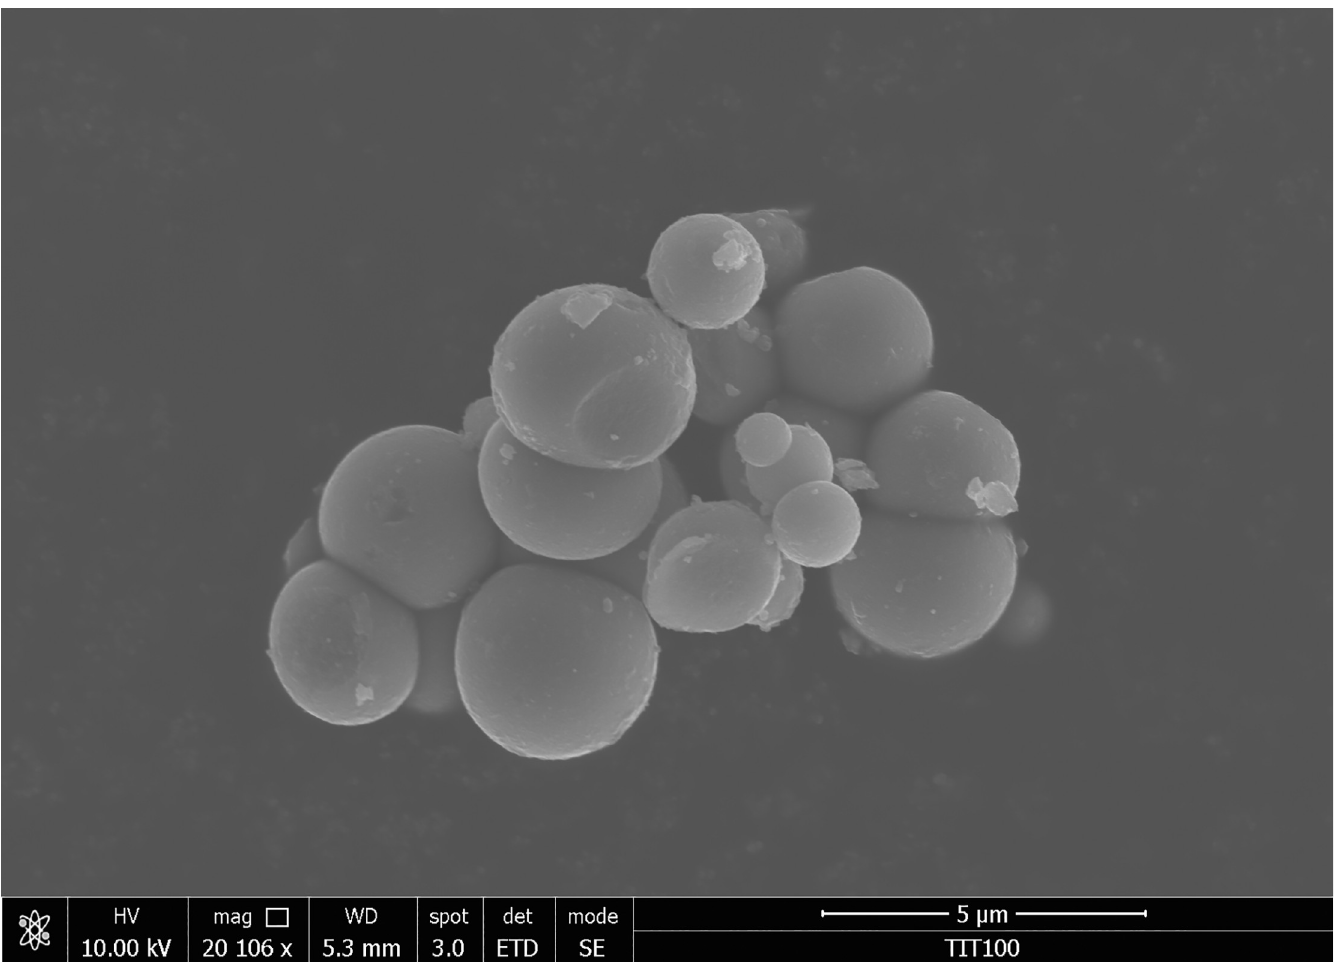
Fig 5. HRSEM image of sample TIT100 prepared by homogeneous precipitation with an initial amount of 100 g TiOSO 4 .